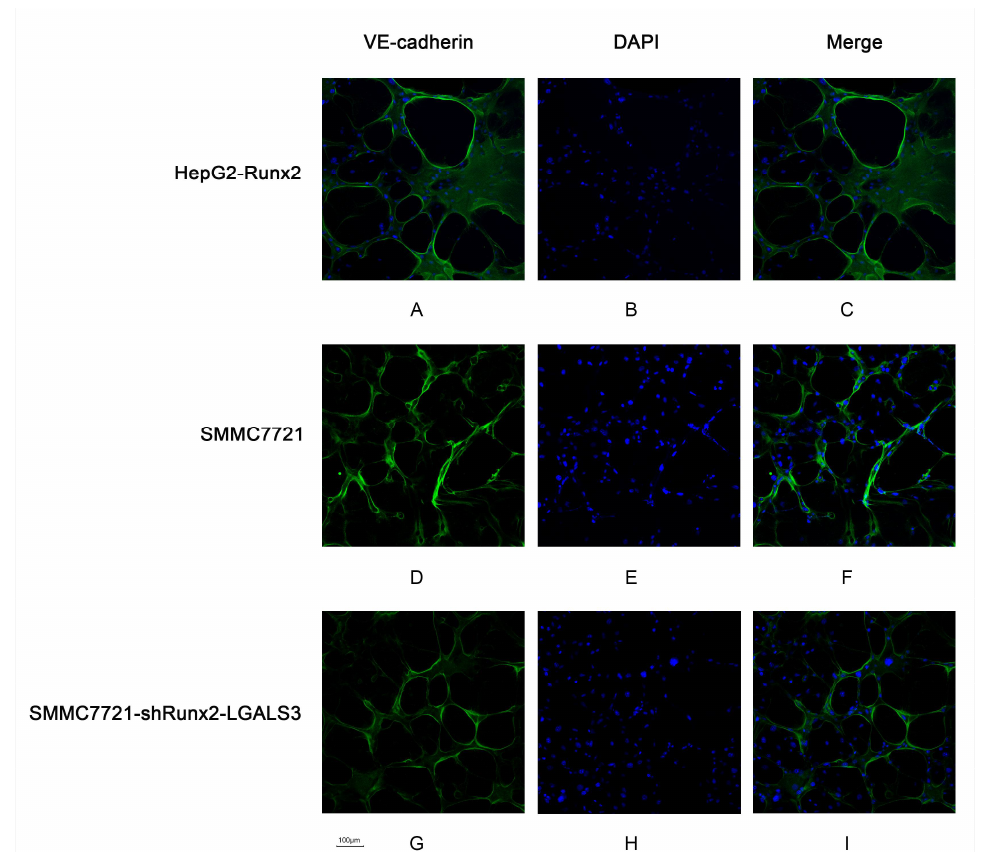
Figure 6. The VM-like tubes formed by HepG2-Runx2 cells, SMMC7721 cells and SMMC7721-shRunx2-LGALS3 cells were assessed by VE-cadherin immunofluorescence and confocal microscopy ( × 200). ( A , D , G ) VE-cadherin staining of the VM channel was concentrated in the wall of the tubes; ( B , E , H ) The cell nuclei were stained by DAPI; ( C , F , I ) The merged images showed that the expression of VE-cadherin in VM networks.